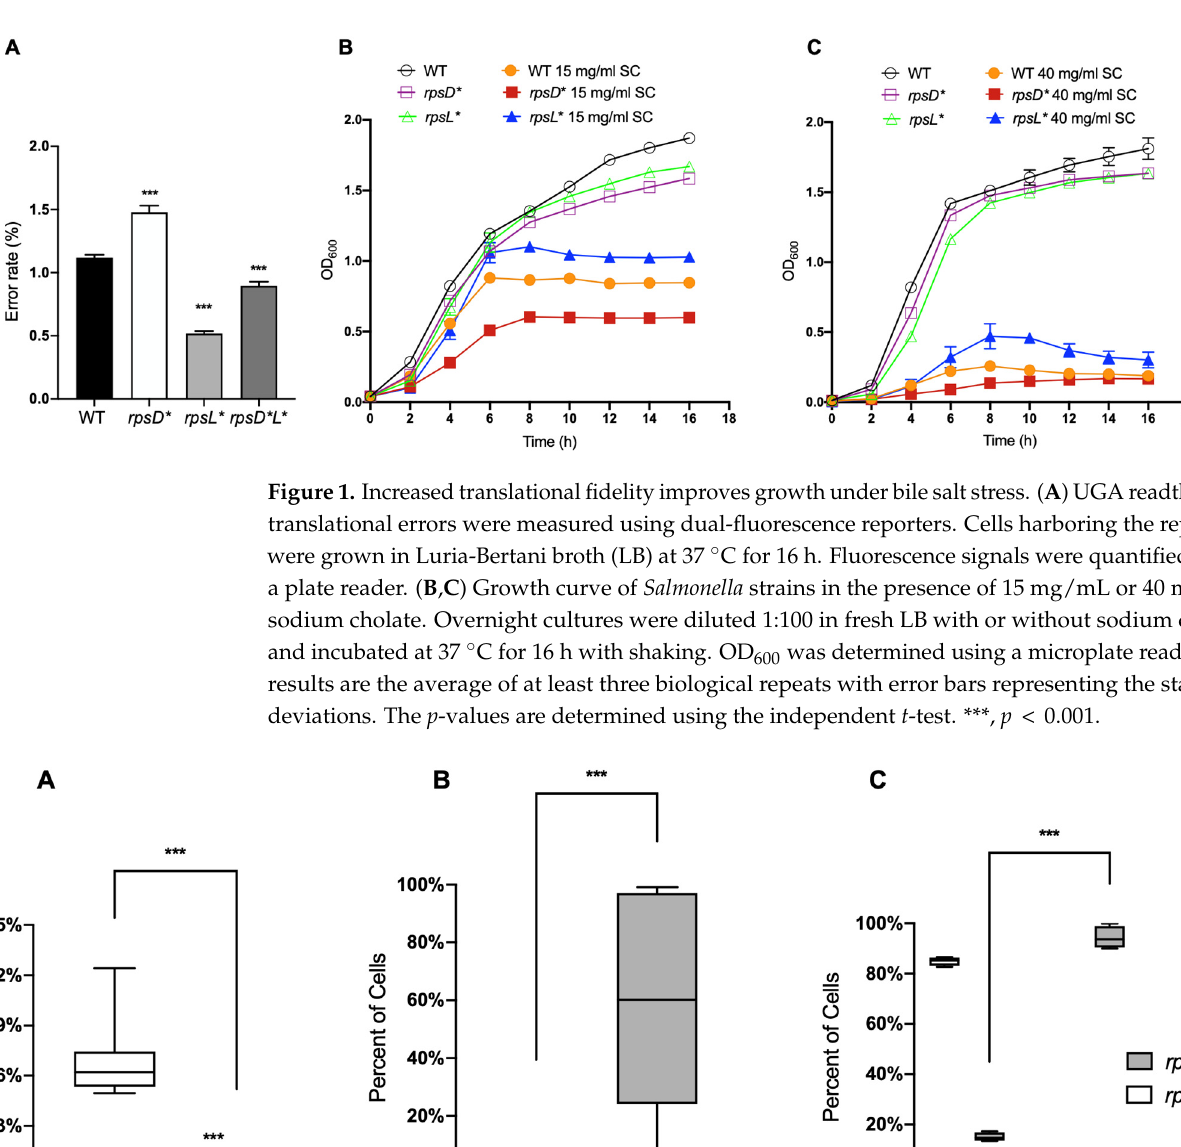
3 of 10 into 1 mL fresh medium for another round of 24 h-competition. The relative fitness was analyzed by a BD LSR II flow cytometer (BD, Franklin Lakes, USA) at a low flow rate. In all, 30,000 gated events were acquired for each sample. Data were further analyzed using the FlowJo software (FlowJo, Ashland, USA). 2.5. Measurement of Intracellular ATP Overnight cultures were diluted 1:100 in fresh LB with or without 20 mg/mL sodium cholate and incubated at 37°C with agitation for 6 h. Cells were normalized by OD 600 , and 1 mL of culture aliquots were collected by centrifugation (14,000 rpm at 4°C for 5 min). The pellets were then resuspended in 500 μ L of phosphate-buffered saline (PBS) and lysed through boiling at 100°C for 10 min. The intracellular ATP level was measured using an ATP Determination Kit (Invitrogen, Thermo Fisher Scientific, Waltham, USA) according to the manufacturer’s instruction. Background ATP was subtracted using the readings of blank PBS. 2.6. Quantitation and Statistical Analysis Three independent experiments with at least three biological replicates were per- formed for each assay. Error bars represent the standard deviation. Statistical differences were analyzed using independent t-tests. p < 0.05 was considered statistically significant. 3. Results 3.1. Higher Translational Fidelity Increases Fitness upon Bile salt Exposure To understand the link between translational fidelity and fitness during exposure in bile salts, we separately introduced mutations I199N and K42N into the ribosomal genes